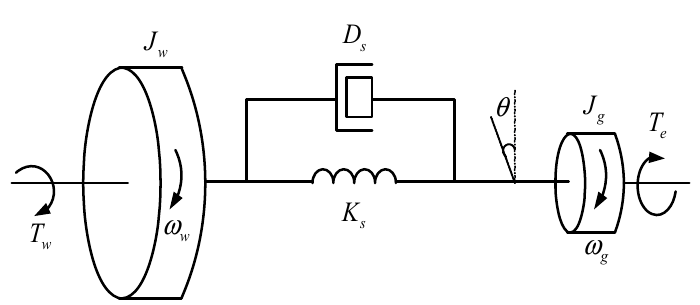
Figure 2. The drive train